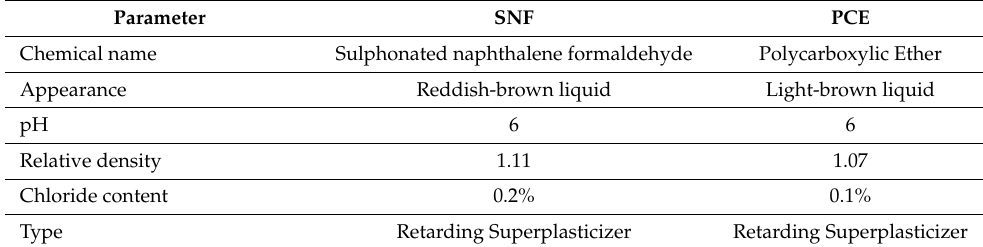
Table 4. Chemical admixture properties.